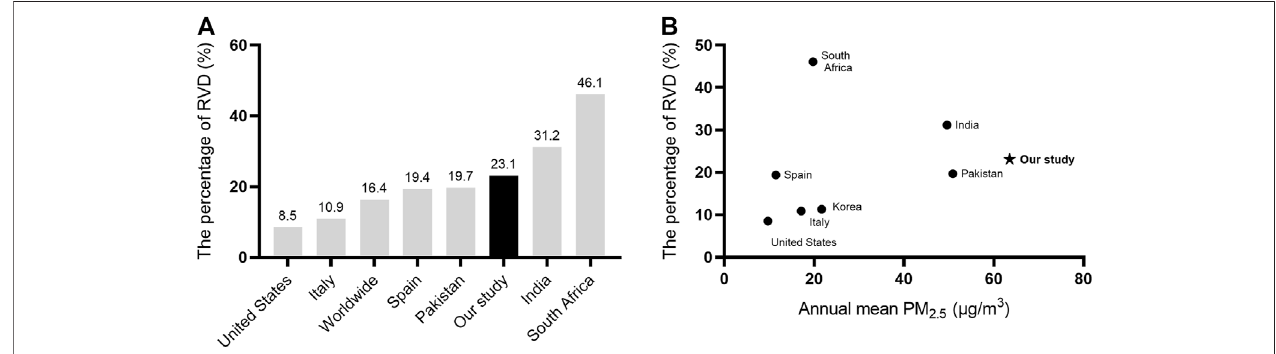
FIGURE 3 | Correlation of RVD with PM 2.5 concentrations in the world. (A) the incidence of RVD in different countries; (B) the correlation between global national annual mean PM 2.5 concentration ( μ g/m 3 ) and the incidence of RVD. AbbreviationsRVD, restrictive ventilatory defect.